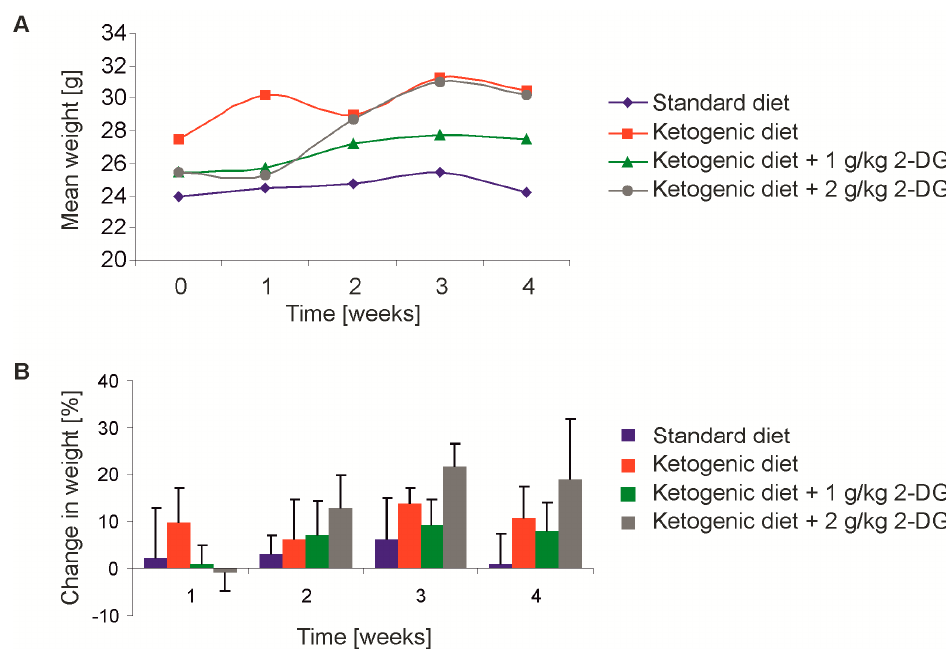
Figure 7. Effects on mouse weight of 2-deoxyglucose and ketogenic diet. The mice were randomized in groups of four mice and fed either a standard diet, calorically-unrestricted ketogenic diet (KD), KD with additional 1 g/kg 2-DG per oral gavage (three/week), or KD with additional 2 g/kg 2-DG (three/week). The combination of KD and 2-DG was well tolerated and we observed no change in the general behavior. ( A ) Over one month, a slight, non-significant increase in total body weight in the ketogenic groups ( p = 0.06, Student’s t -test) was detected. ( B ) Change in body weight of mice relative to the start of the dietary intervention ( n = 4, mean + SD).